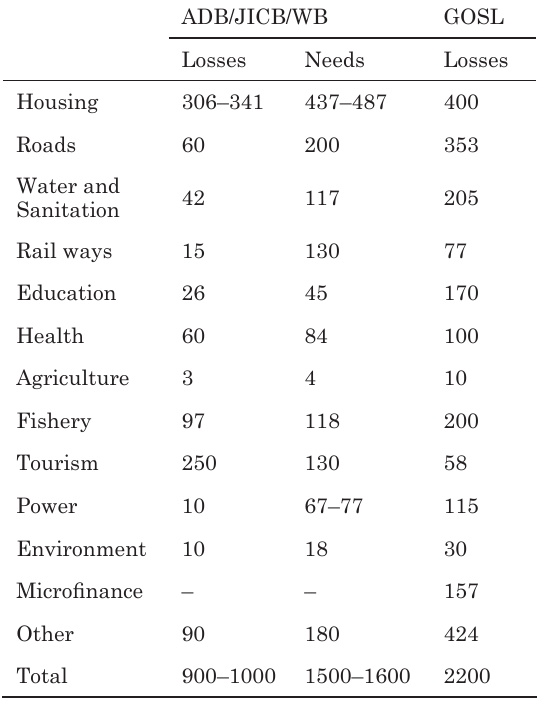
table 1. Estimates of needs assessment for reconstruction and rebuilding (Us$